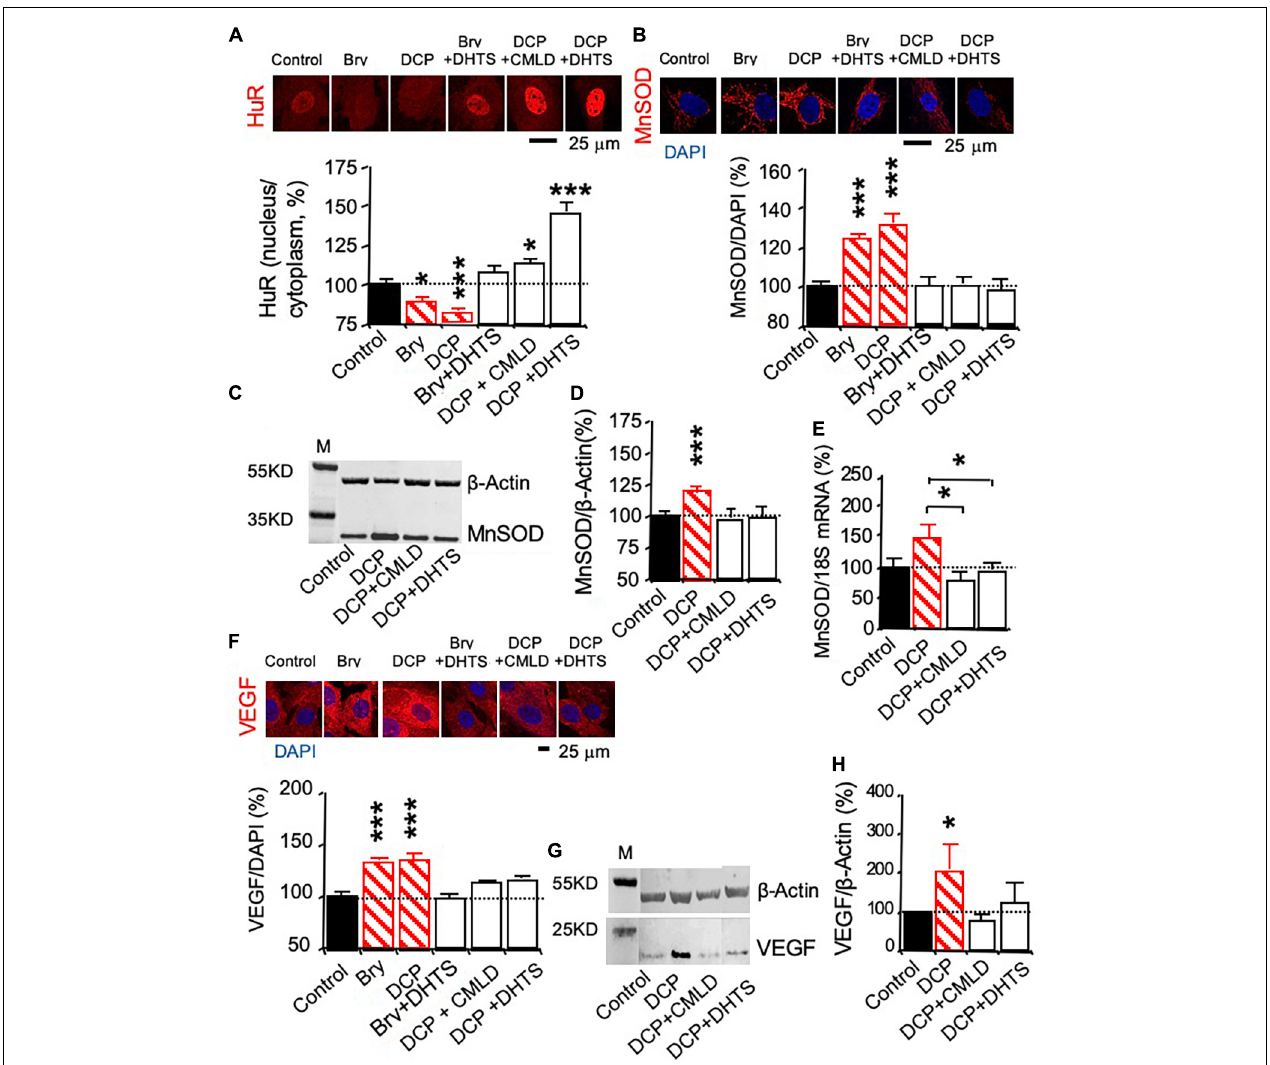
FIGURE 4 | The mRNA-stabilizing protein HuR involved in PKC ε -activated MnSOD and VEGF expression in human brain microvascular endothelial cells (HBMEC). HBMEC cells were treated with the HuR inhibitor CMLD-2 (35 µ M) or dihydrotanshinone-I (DHTS, 10 µ M) for 30 min before and during the 3-day incubation in the presence of the PKC ε activator bryostatin (25 nM) or DCPLA-ME (100 nM). (A) Immunohistochemistry of HuR was used to study nuclear export of the HuR protein. (B) Immunohistochemistry and (C,D) western blot analysis of MnSOD protein expression. (E) Quantitative PCR (qPCR) of MnSOD mRNA expression. (F) Immunohistochemistry and (G,H) western blot analysis of VEGF protein expression. M, molecular weight marker. Data are represented as mean ± SEM, * p < 0.05; *** p < 0.001; one-way ANOVA and post hoc Tukey’s multiple comparison test ( n = 59–134 MnSOD-immunostained cells or 451–907 PKC ε or VEGF-immunostained cells from 3 to 4 cultures/group or t -test ( n = 3 cultures/western blot group).